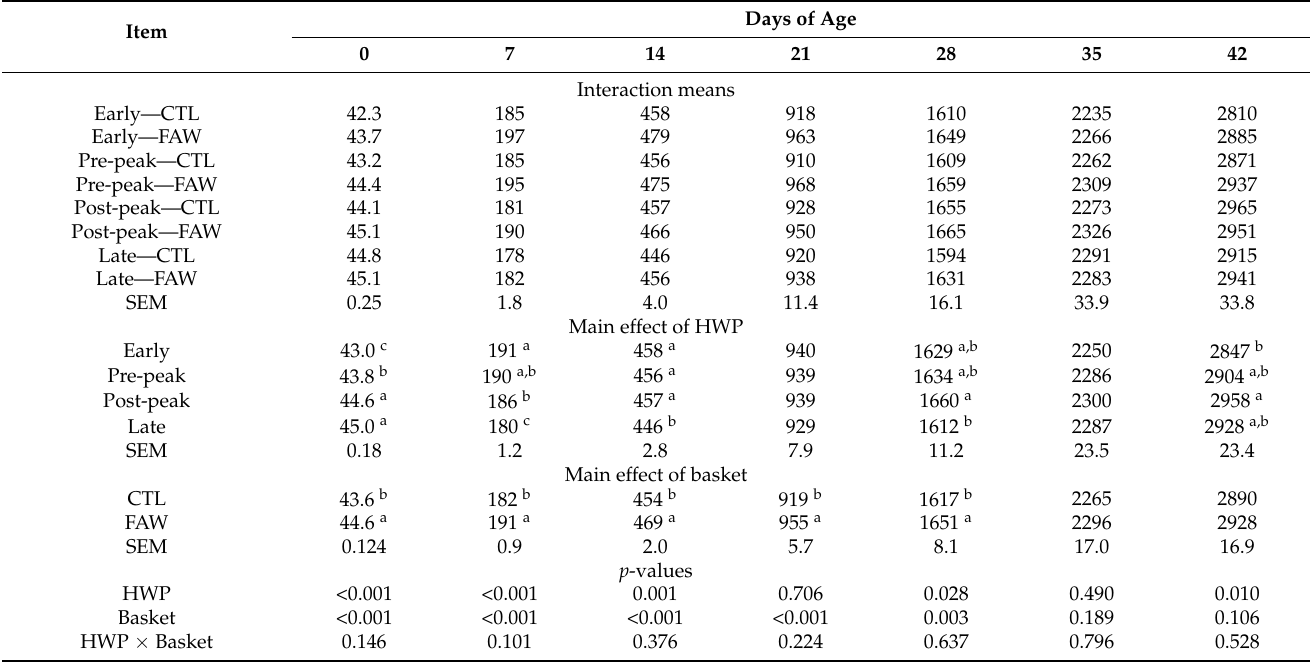
Table 4. Body weight (g) of broilers from different hatch window periods (HWP) within a single hatch window provided feed and water (FAW) in the hatching basket compared to a control (CTL) 1 .